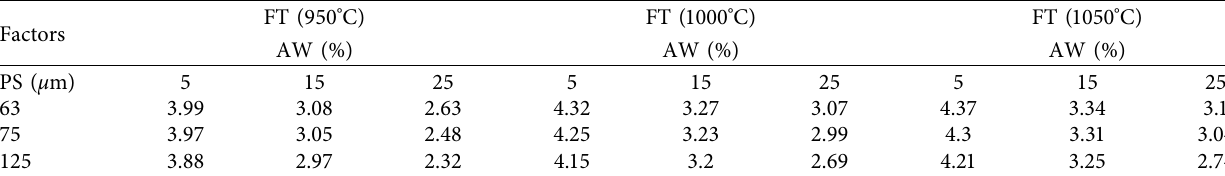
Table 2: The average value of